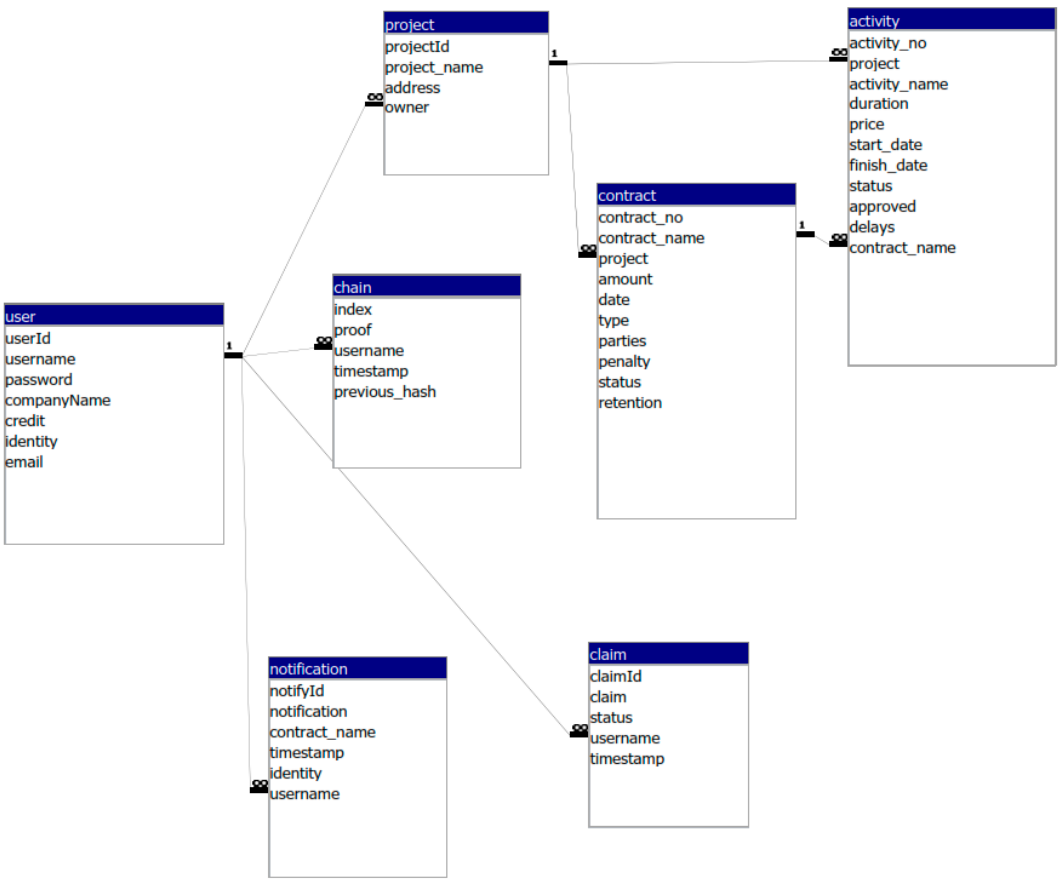
Figure 7. Prototype’s database schema.